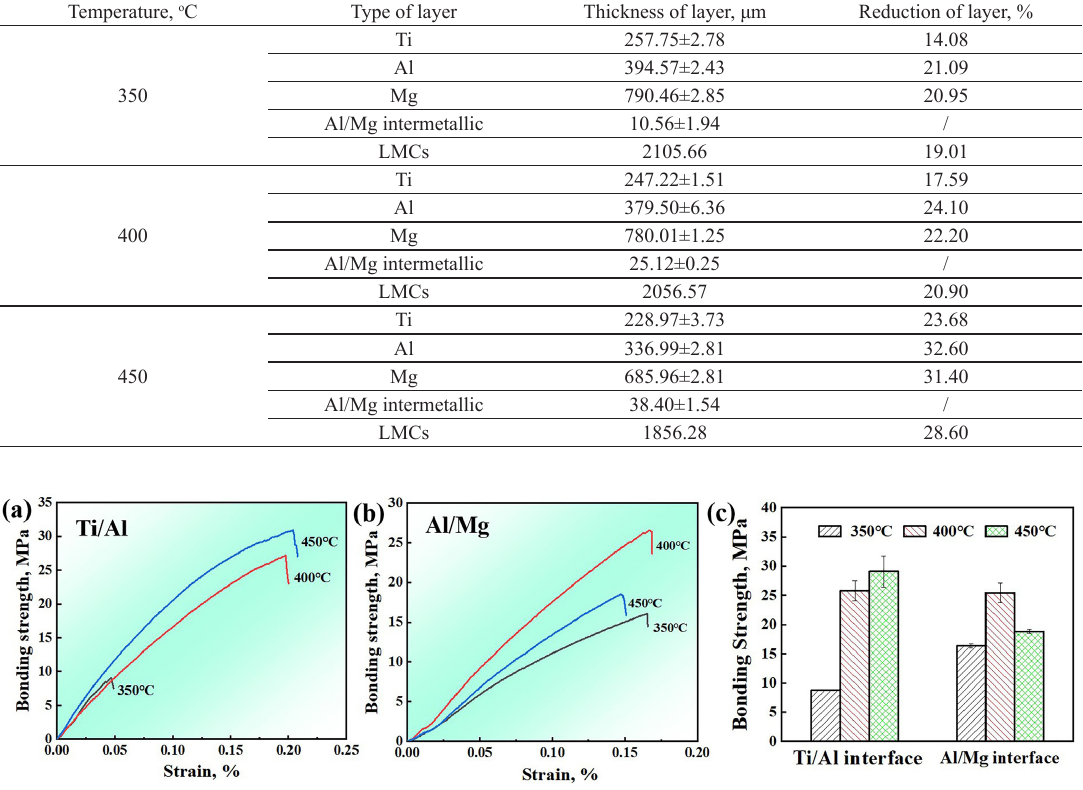
Table 1. The thickness of Ti, Al, Mg and Al/Mg intermetallic layers in LMCs after hot-pressing at different hot-pressing temperatures. Temperature, o C